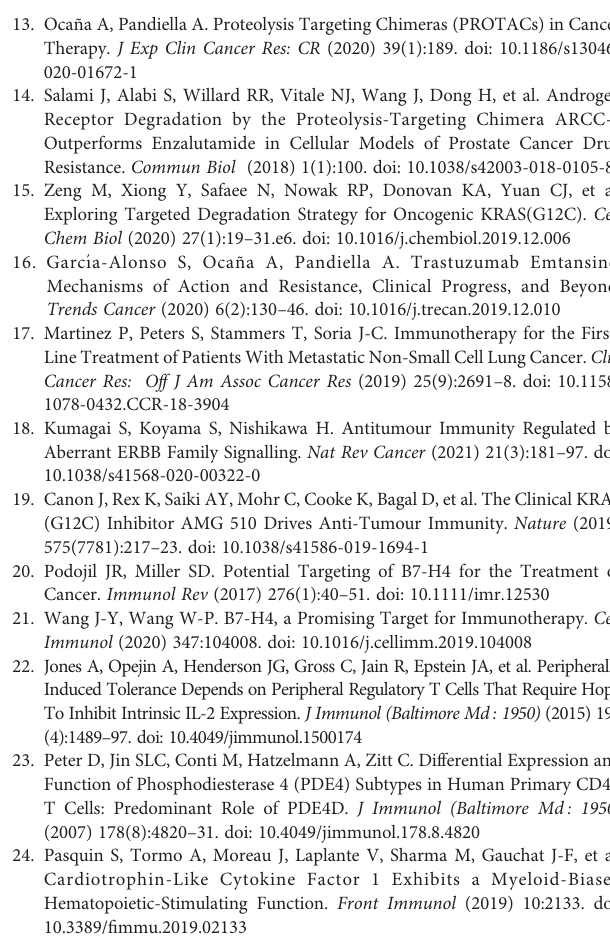
Supplementary Figure 2 | Negative correlation between the expression of upregulated genes ( CLRF1, HOPX, IRS2, KIT, PDE4D , and SMOC1 ) and most of immune in fi ltrates (CD8+ T cells, Neutrophils, Macrophages and dendritic cells). A green square encircles the dots with higher expression and little in fi ltration level. Supplementary Figure 3 | Positive correlation between the expression of downregulated genes ( CD24, CDK6, HDAC9, TIAM1, TRFC, VTRC1, and VAV3 ) and mostofimmunein fi ltrates(CD8+Tcells,Neutrophils,Macrophagesanddendriticcells). A yellow square encircles the dots with less expression and more in fi ltration level. Supplementary Figure 4 | Expression of CLDN10 and TMPRSS6 in different human cancer types. Bar graph showing the expression of individual CLDN1 0 (in (A) , TMPRSS6 in (B) or both genes combined (C) in those cancer types where